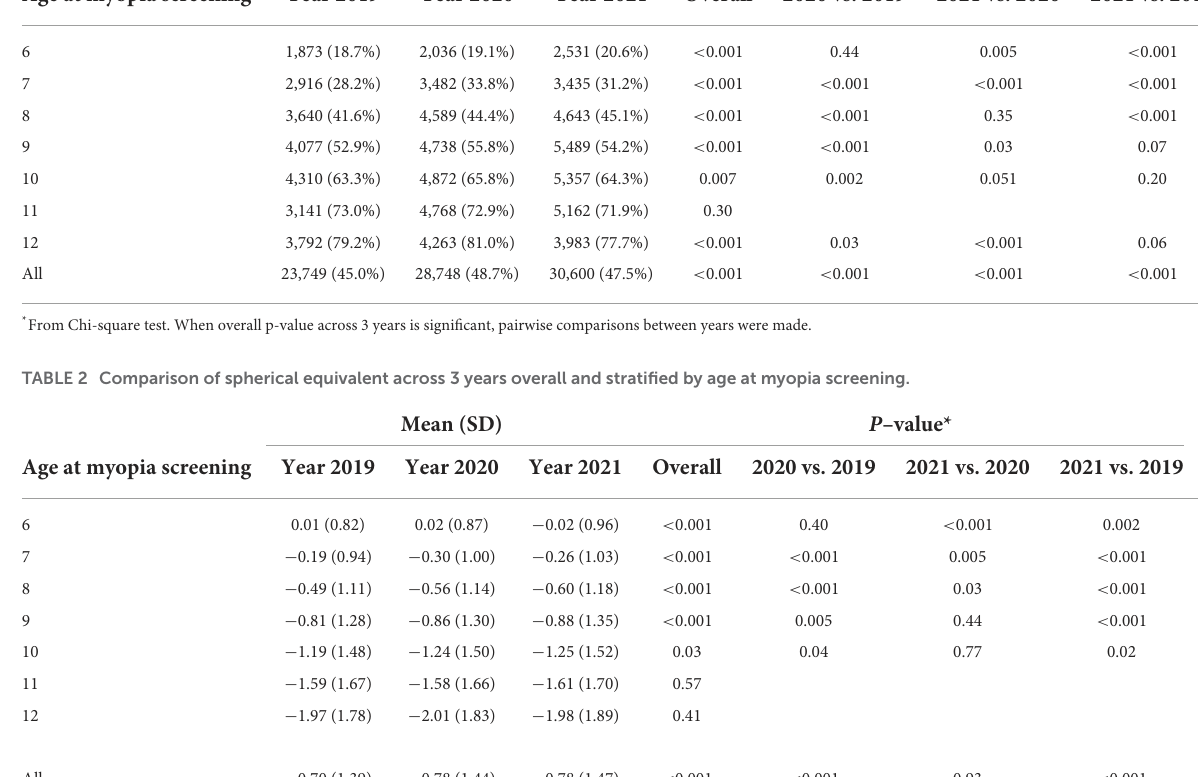
TABLE 1 Comparisons of myopia prevalence rate across 3 years overall and stratified by age at myopia screening. Myopia (%) p -value* Age at myopia screening